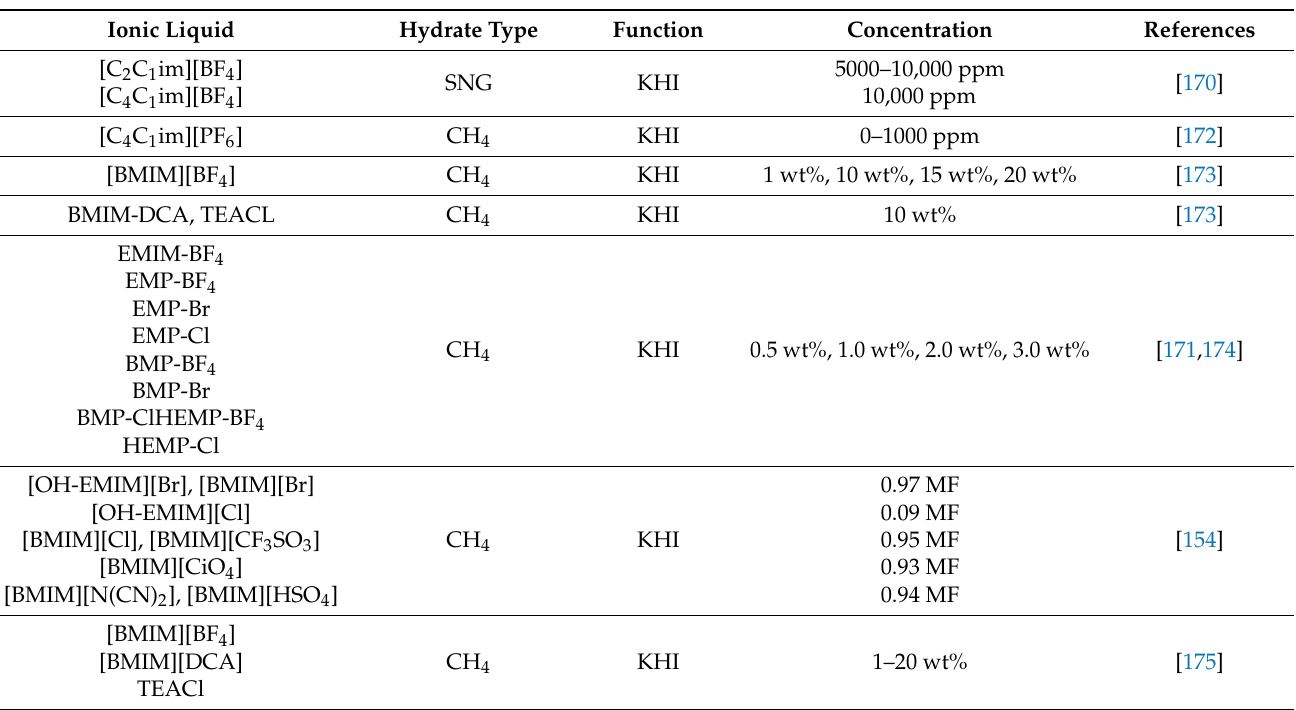
Table 9. Summary of ionic liquids used as KHIs in oil/gas